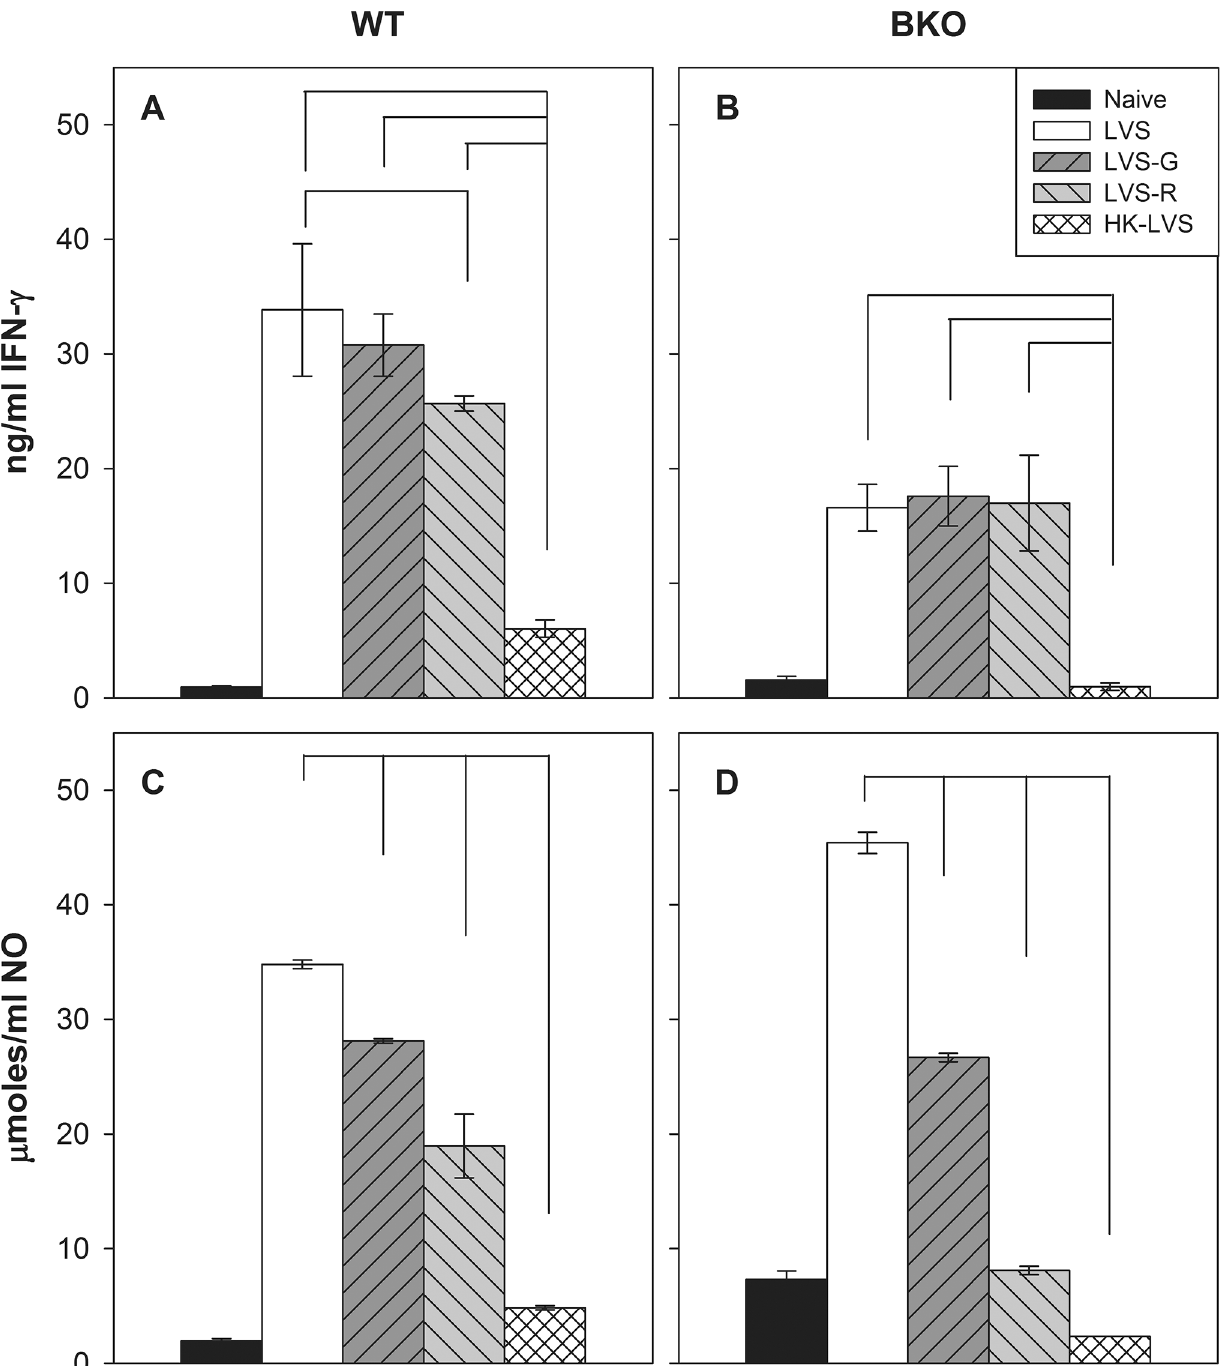
Fig 2. IFN- γ and NO production exhibit patterns mostly similar to that of in vitro LVS replication. Supernatants from co-cultures described in Fig 1 using splenocytes of BALB/cByJ mice (Panels A and C) and BKO mice (Panels B and D) were collected after two days of co-culture, and separated from cells for analyses of IFN- γ by ELISA (Panels A and B) and NO by Griess reaction (Panels C and D). Concentrations were calculated using standard curves as reference. Values shown are the mean concentration in ng/ml (IFN- γ ) or μ moles (NO) ± standard deviation of triplicate samples. Results shown are from one representative experiment of seven (using splenocytes of BALB/cByJ mice) or four (using splenocytes of BKO mice) independent experiments of similar design and outcome. Brackets indicate a significant difference ( P < 0.05) between amounts of IFN- γ or NO produced in co-cultures. There were no significant differences in IFN- γ production between the co-cultures using LVS-immune cells and the co-cultures using LVS-G-immune cells (Panel A), between the co- cultures using LVS-G-immune cells and the co-cultures using LVS-R-immune cells (Panel A), and between the co-cultures using LVS-immune cells and the co-cultures using LVS-G-immune cells or LVS-R-immune cells (Panel B). doi:10.1371/journal.pone.0126570.g002 PLOS ONE | DOI:10.1371/journal.pone.0126570 May 14,